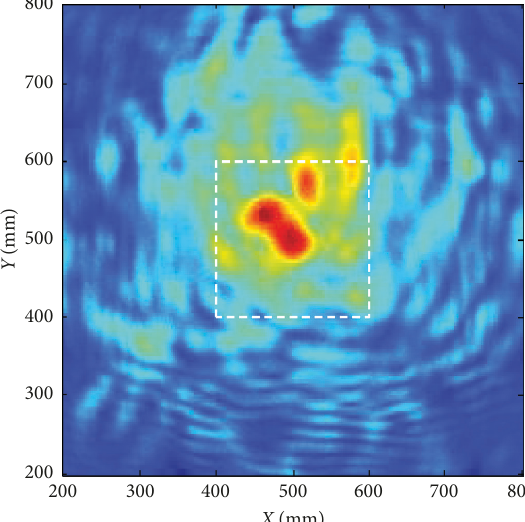
Figure 15: TDTE imaging experimental results.